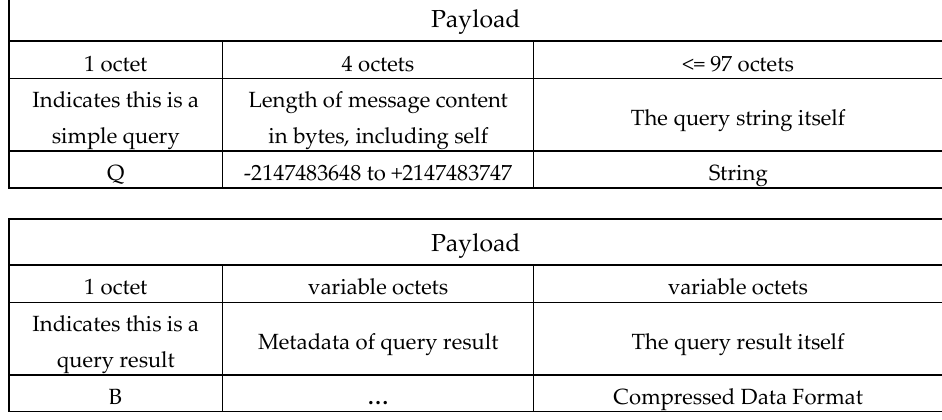
Figure 8. The packet format of the query instruction and query result.